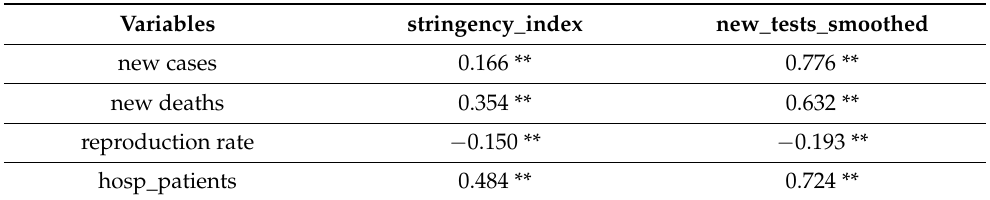
Table 5. Spearman’s r s correlation indexes calculated between variables indicating restrictions and intensity of the disease for Poland.